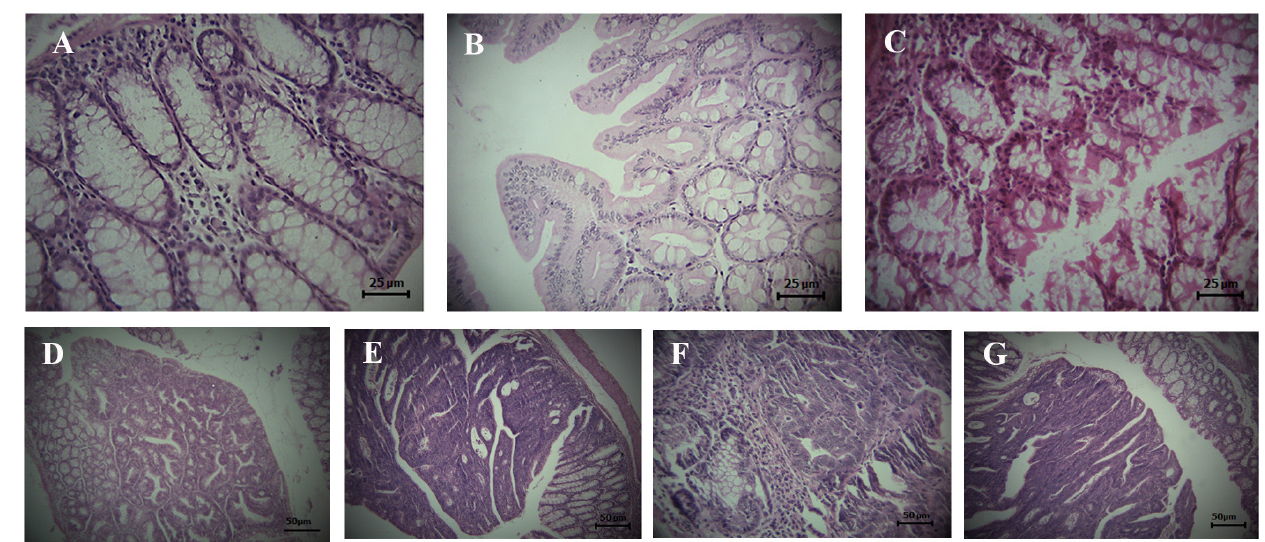
FIGURE 3 - Histopathologic indexes of distal colon after hematoxylin-eosin staining A: Normal Control, B: Hyperplasia, C: Mild Dysplasia, D: Moderate Dysplasia, E: Severe Dysplasia, F: Insitu Carcinoma, G: Invasive Carcinoma.